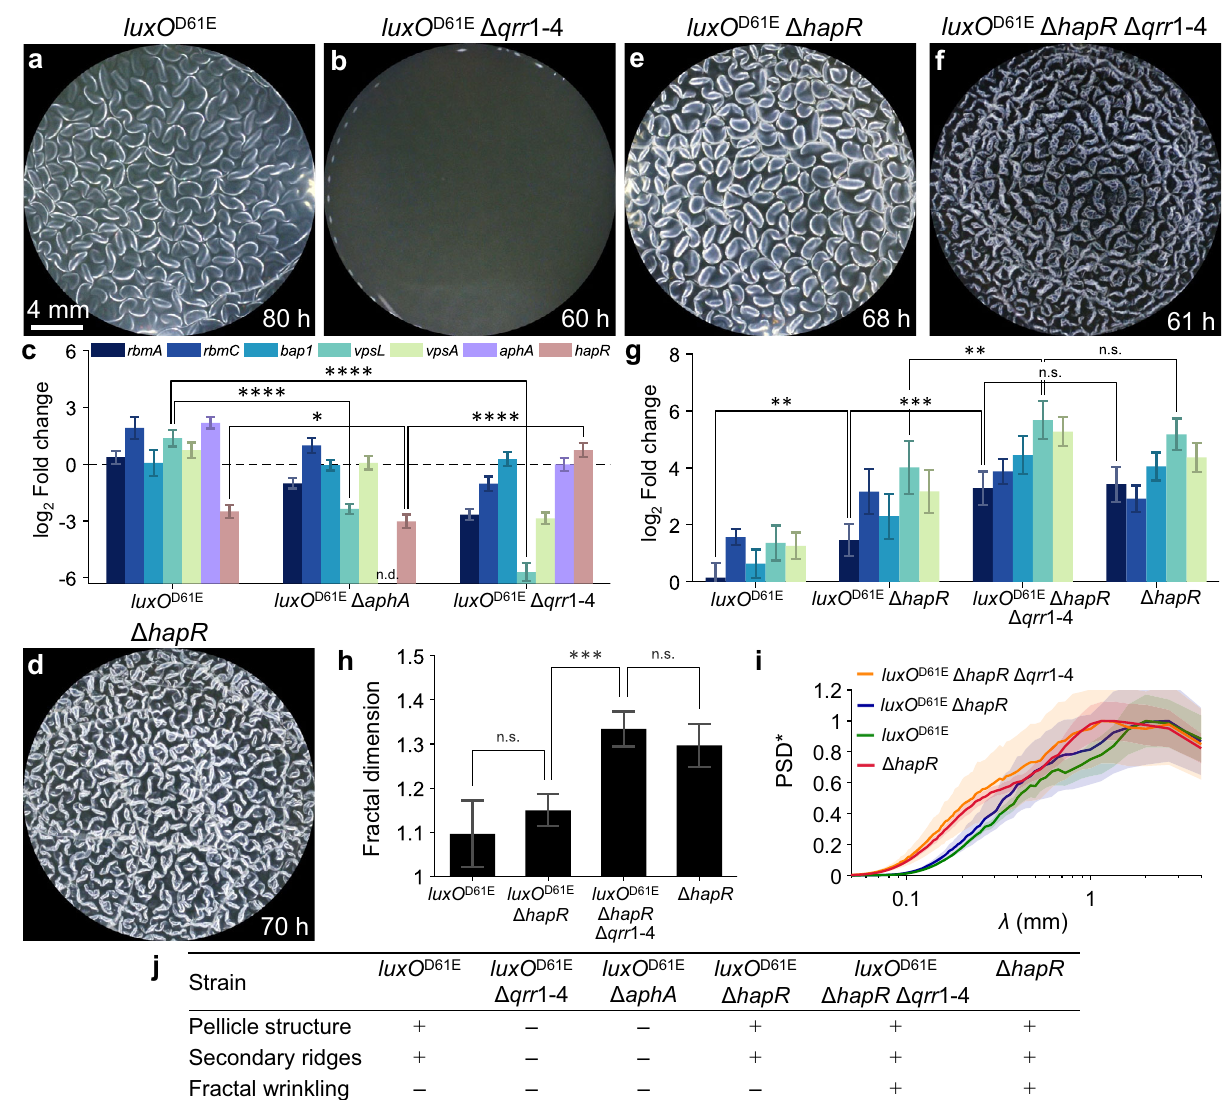
Fig. 5 | V. cholerae QS mutants are defective in pellicle morphogenesis devel- opment and the Qrr sRNAs suppress fractal wrinkling by repressing genes encoding matrix proteins. a , b , d , e , f Pellicle morphologies for the indicated strains at the indicated time points. c Expression of the indicated genes in the designated strains assessed by qRT-PCR. Data are presented relative to that from wildtype V. cholerae . g Expression pro fi les of key matrix genes in the designated QS mutants. Color scheme is shown in c . Data are presented relative to that from